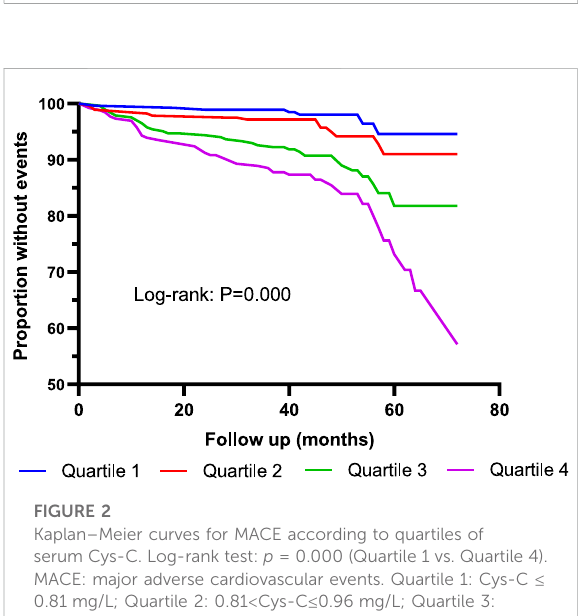
FIGURE 2 Kaplan – Meier curves for MACE according to quartiles of serum Cys-C. Log-rank test: p = 0.000 (Quartile 1 vs. Quartile 4). MACE: major adverse cardiovascular events. Quartile 1: Cys-C ≤ 0.81 mg/L; Quartile 2: 0.81 < Cys-C ≤ 0.96 mg/L; Quartile 3: 0.97 ≤ Cys-C ≤ 1.13 mg/L; Quartile 4: Cys-C ≥ 1.14 mg/L.